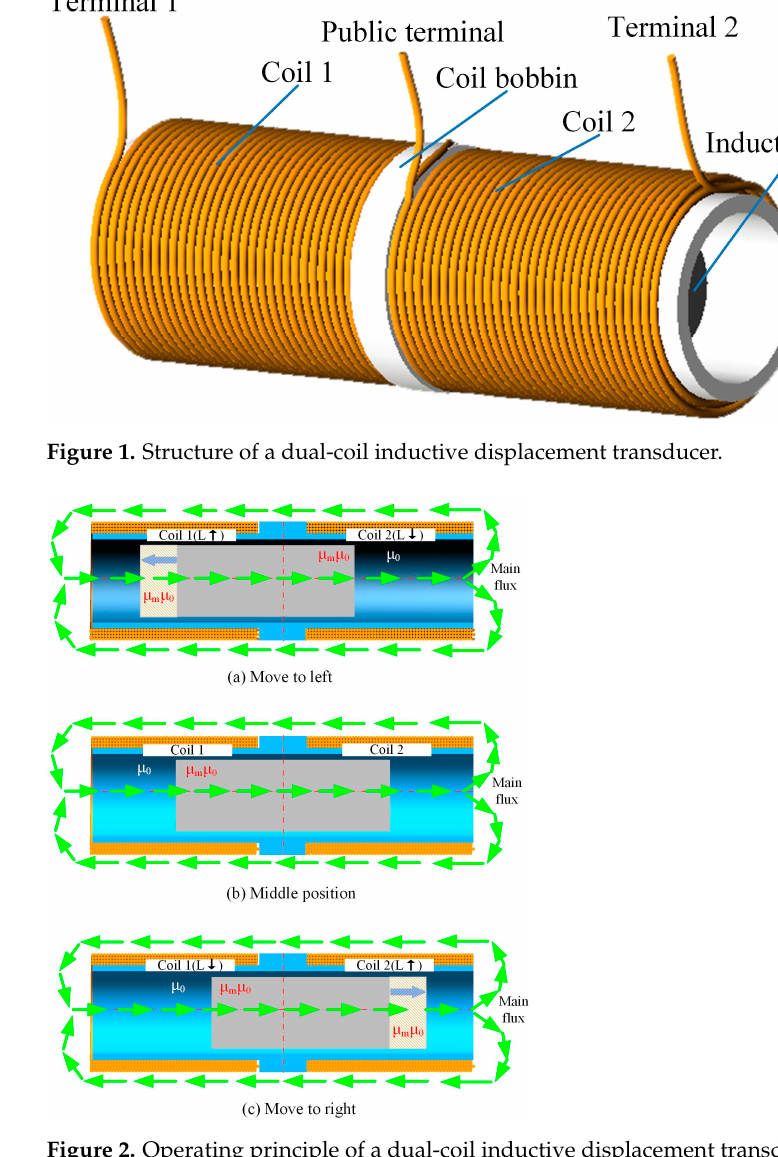
Figure 1. Structure of a dual-coil inductive displacement transducer.